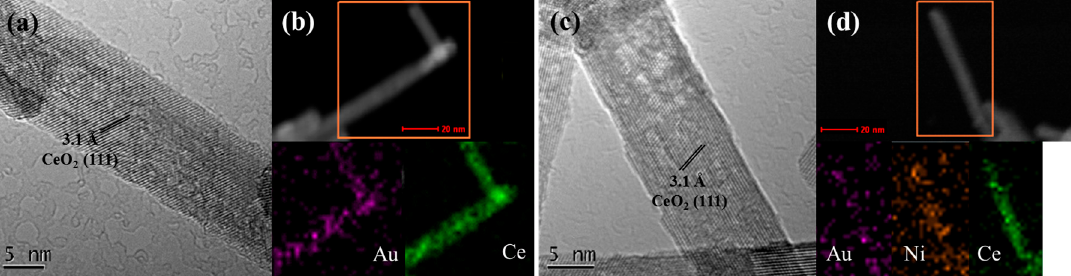
Figure 3. HRTEM images ( a , c ) and STEM-EDS mapping results ( b , d ) of fresh AuNi/CeO 2 samples: ( a , b ) AuCe ; ( c , d ) AuNiCe .